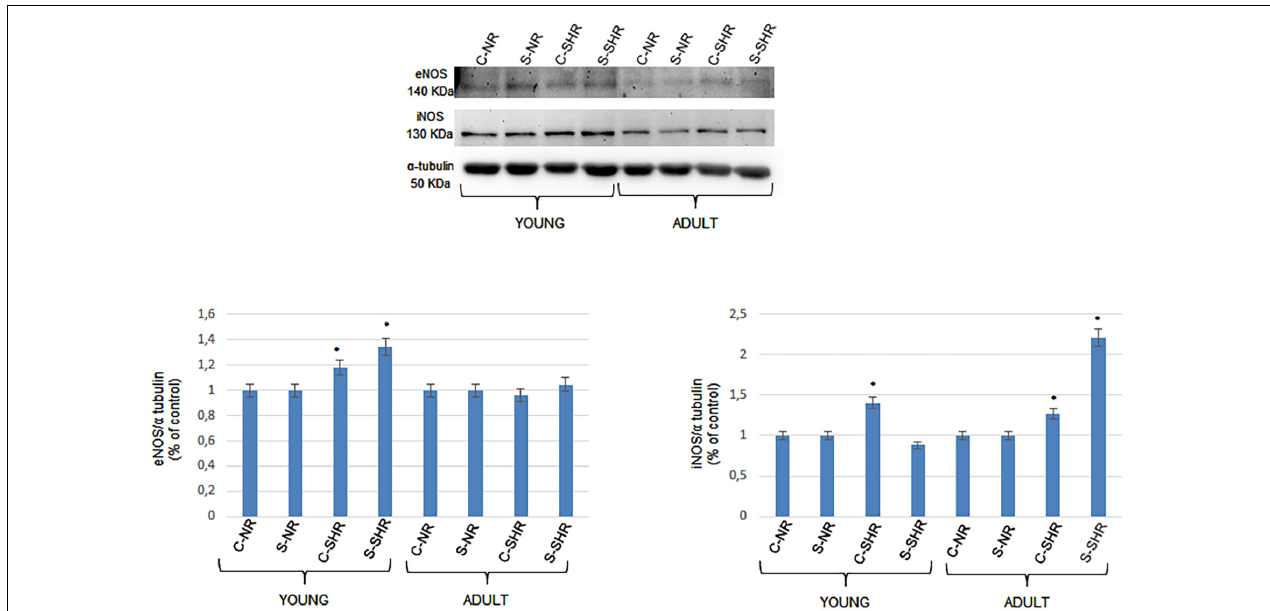
FIGURE 4 | Western blotting of endothelial (eNOS) and inducible nitric oxide synthase (iNOS) expression in two cerebral zones (cortex and striatum) in young age-matched normotensive rats, in young spontaneously hypertensive rats (SHRs), in adult age-matched normotensive rats, and in adult SHRs. Bottom : corresponding densitometric values (mean ± SD). C-NR , cortex of normotensive rats; S-NR , striatum of normotensive rats; C-SHR , cortex of SHRs; S-SHR , striatum of SHRs. * p < 0.01 vs. age-matched normotensive